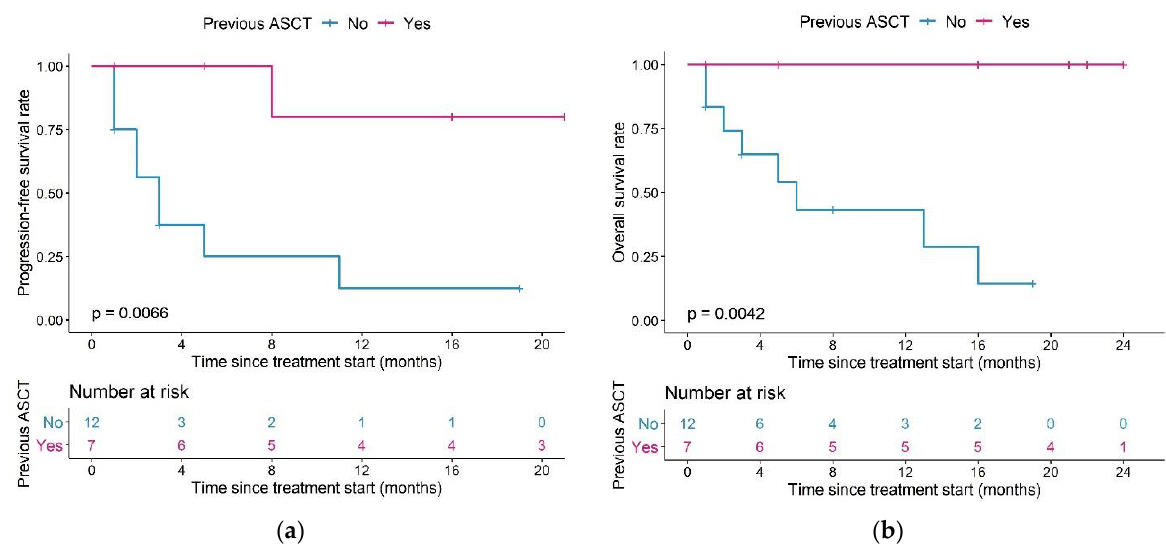
Figure 7. Kaplan – Meier plots for ( a ) progression-free survival and ( b ) overall survival in patients having undergone (magenta) or having or not undergone (blue) a previous ASCT; log-rank tests. Abbreviations — ASCT: autologous stem cell transplantation.